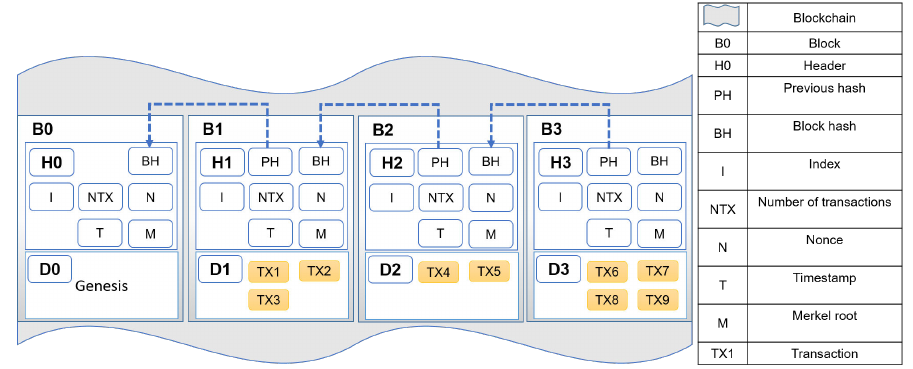
Figure 1. Blockchain